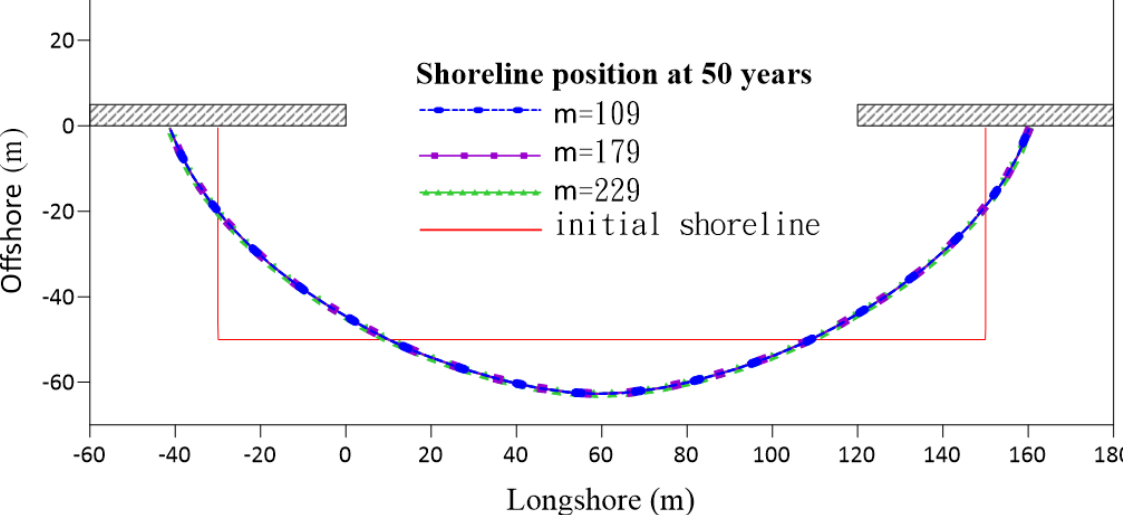
Figure 7. The profiles of initial shoreline and steady shoreline by using different numbers of control volume ( ∆ t = 0.01 s).